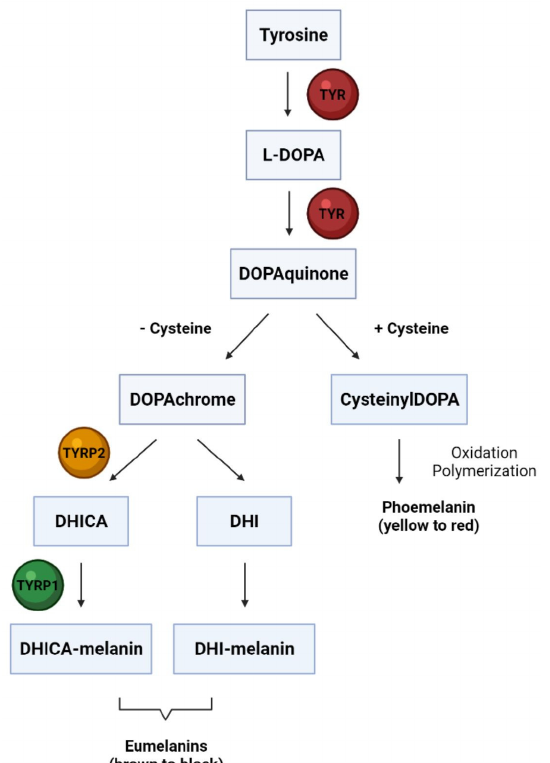
Figure 1. Schematic presentation of melanin synthesis during melanogenesis in melanocytes. [Created by BioRender].